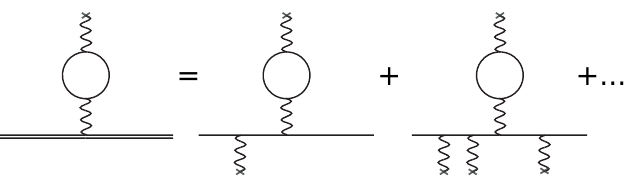
Figure 5 . The expansion of the 1PR contribution to the scalar propagator in the crossed (cid:12)eld case. Note that in Fock-Schwinger gauge there is an odd number of free low energy photons of the background coupled to the line, and one low energy photon attached to the loop as